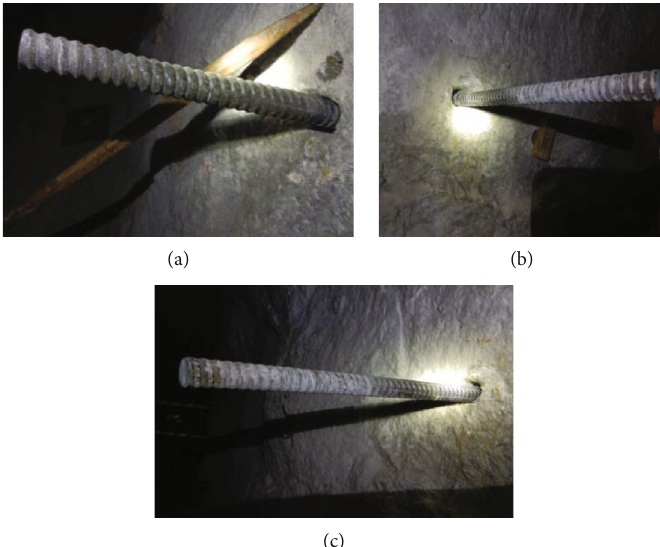
Figure 10: Condition of the rod after completion of the test. (a) Anchor rod no. 1. (b) Anchor rod no. 2. (c) Anchor rod no.